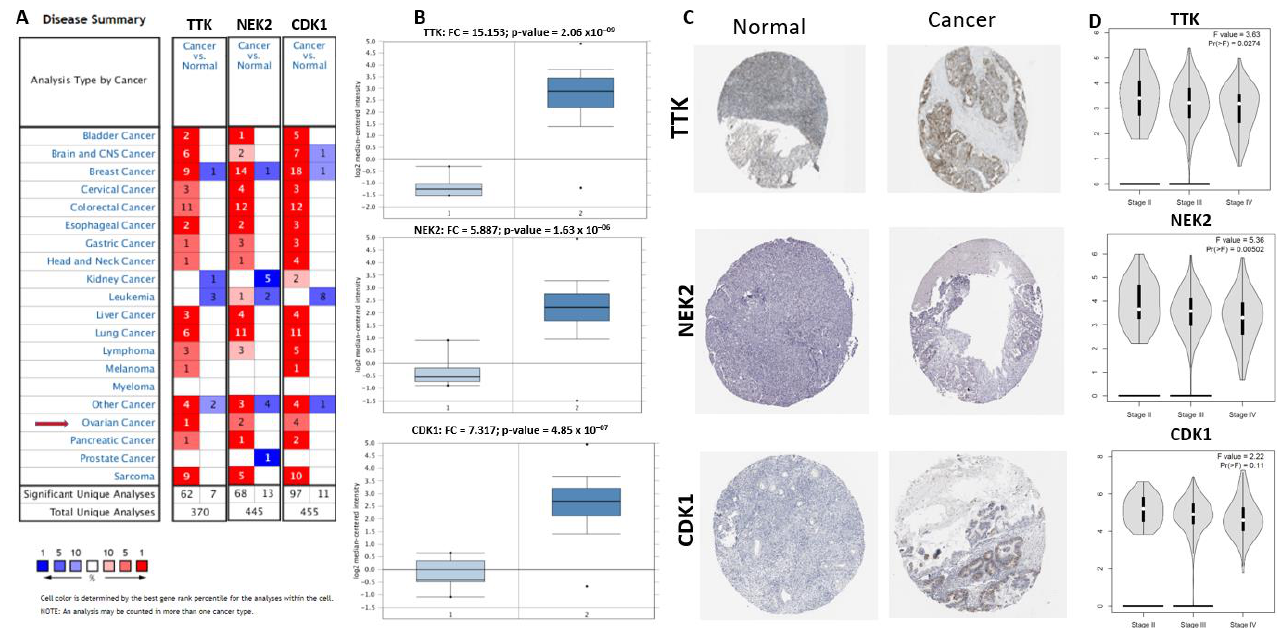
Figure 5. Expression profiles and roles of the TTK, NEK2, and CDK1 genes in ovarian cancer. ( A ) Expressions of TTK, NEK2, and CDK1 in all tumor studies in the Oncomine database. ( B ) Expressions of TTK, NEK2, and CDK1 in chips of different ovarian cancer studies within the Oncomine database. ( C ) Expressions of TTK, NEK2, and CDK1 in ovarian cancer tissues and normal tissues in the Human Protein Atlas. ( D ) Correlations between TTK, NEK2, and CDK1 expressions and tumor stage in ovarian cancer patients. From the GEPIA database, a violin plot was derived from correlations of TTK, NEK2, and CDK1 expressions with the tumor stage in patients with ovarian carcinoma; the p -value was set to 0.05. The abscissa indicates the stage of ovarian cancer, and the ordinate indicates expression levels of TTK, NEK2, and CDK1.